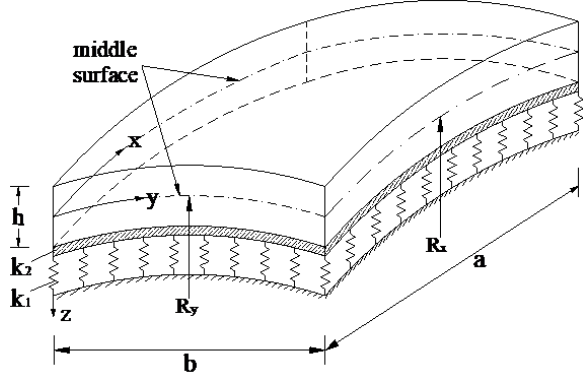
Fig. 1: Configuration and coordinate system of a doubly curved panel on an elastic foundation.